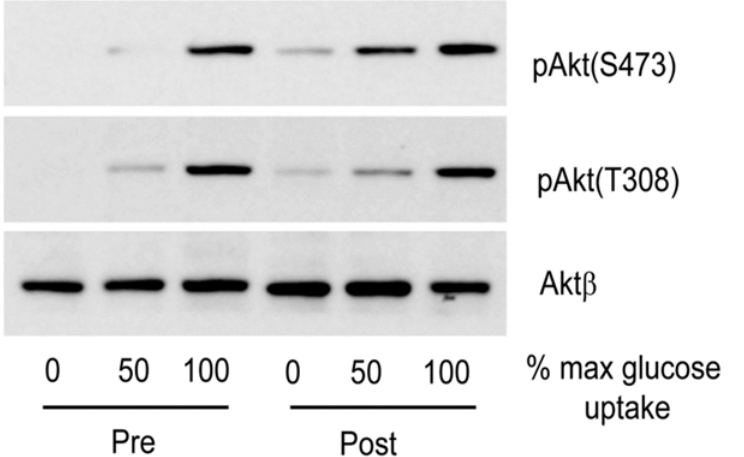
Fig 3. Insulin signalling in obese volunteers, pre and post weight loss surgery. Obese volunteers (pre and post-op) underwent a 3-hour euglycaemic hyperinsulinaemic clamp and muscle biopsies were taken at fasting (0) and insulin infusion rates predicted to achieve half maximal (GDR 50 ) and maximal (GDR 100 ) rates of glucose disposal. The extent of phosphorylation of Akt on Thr308, Ser473 and PRAS40 on T246 was determined by western blotting. The results shown are from a single individual, but are representative of the eight obese volunteers [see Materials and Methods].